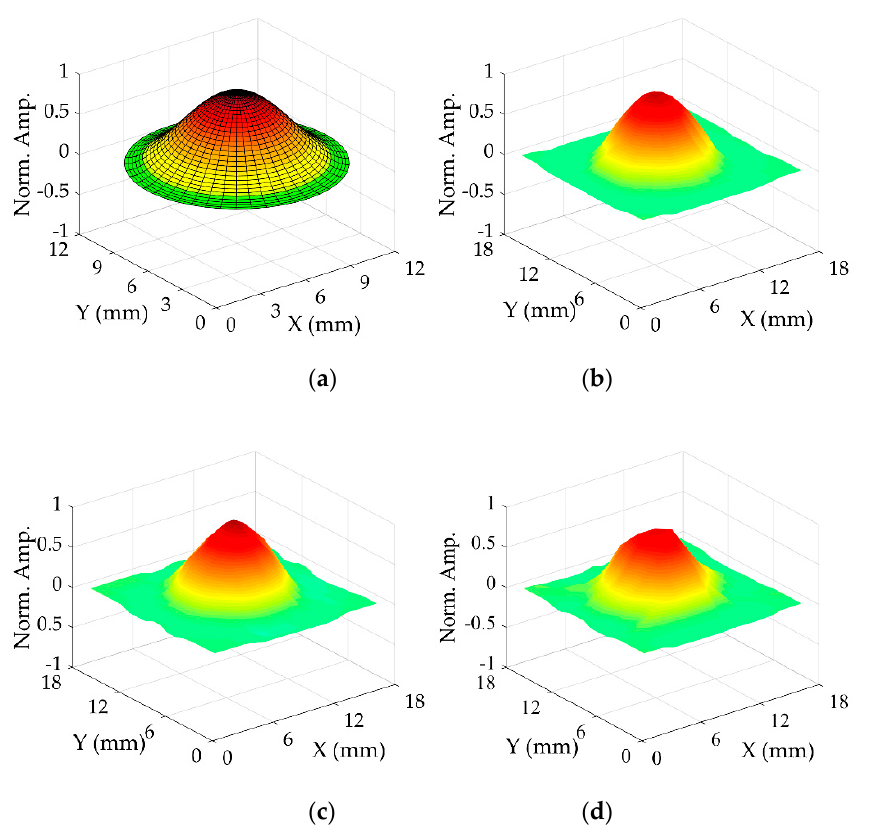
Figure 4. Mode shapes of each transducer displaying the fundamental (0,0) mode: (a) mathematically represented; and through laser Doppler vibrometry: (b) the CFUT; (c) VFUT 1 ; (d) VFUT 2 . The vibration amplitudes of each mode shape have been individually normalized.